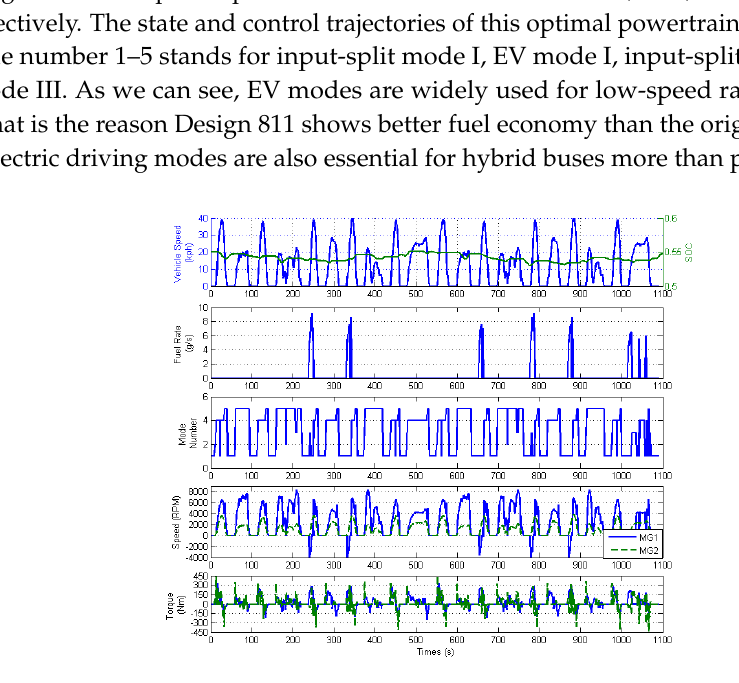
Manhattan cycle by near-optimal control strategy